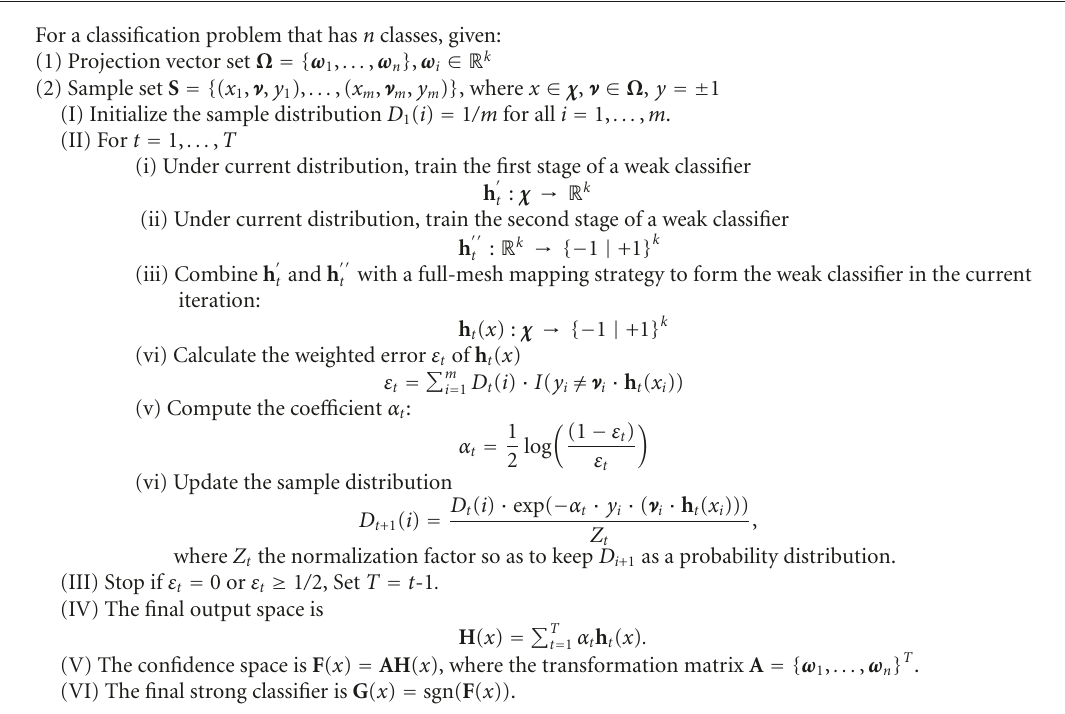
Algorithm 2: A Generalized description of the fine-classified boosting